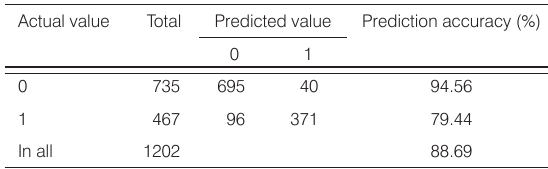
Table 3. Confusion matrix from prediction results of GDM incidence in the F1 model.